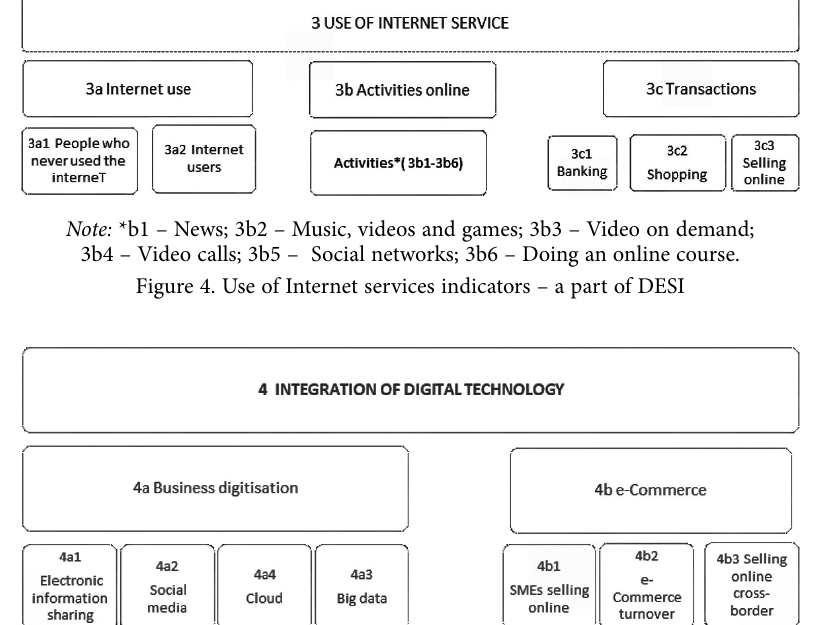
Figure 5. Indicators of dimension “Integration of digital